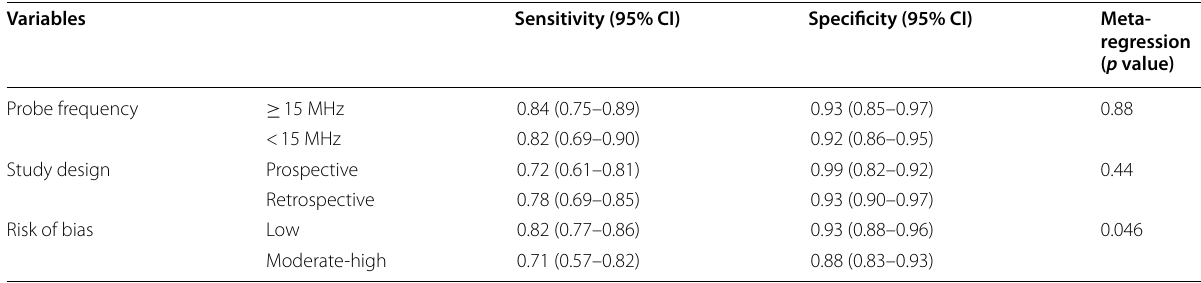
95% CI 95% confidence interval